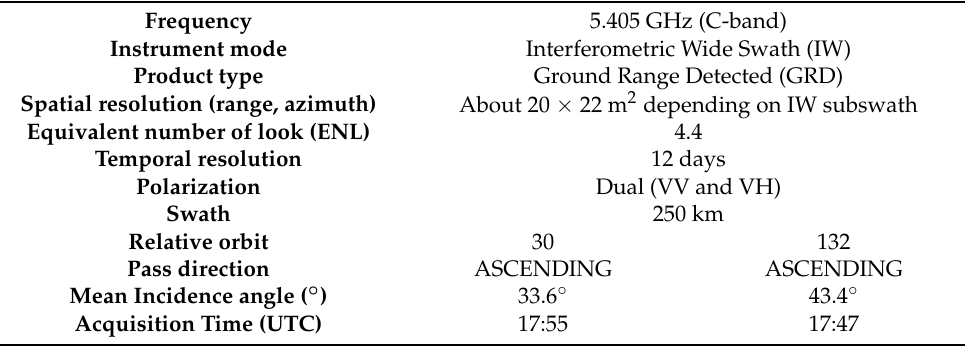
Table 3. Main characteristics of Sentinel-1A images.